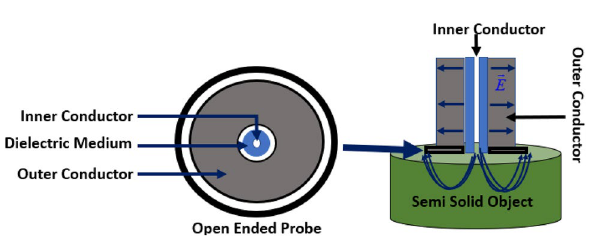
Figure 4. Cross-section schematics of the probe with electric field orientation.